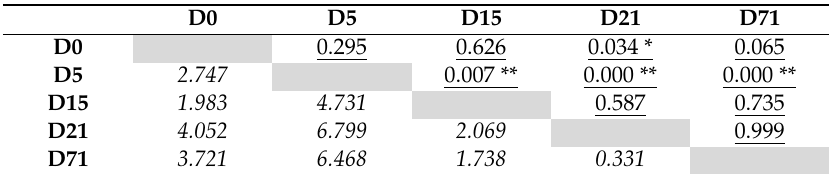
Table 2. The t -values (italics) and p -values (underlined) of Tukey’s test for the detection of statistically significant di ff erences of the operational taxonomic units (OTU) in Sparus aurata larvae from day (D) zero to day 71. *: p < 0.05, **: p < 0.002. p -values are corrected for multiple comparisons.